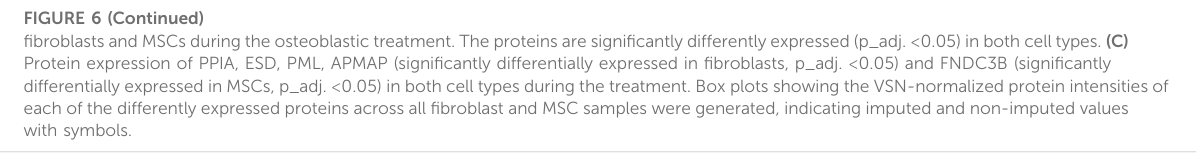
TABLE 1 Genes, proteins, and phosphoproteins associated with osteogenesis. Gene Function in osteogenic differentiation Regulation CLIP Novel regulator of matrix mineralization (Staines et al., 2014) ↑ SOD2 Eliminator of excess mitochondrial superoxide and protein oxidation that is needed for osteoblastic differentiation and bone formation (Gao et al., 2018) Involved in osteogenic differentiation (Lin et al., 2021)